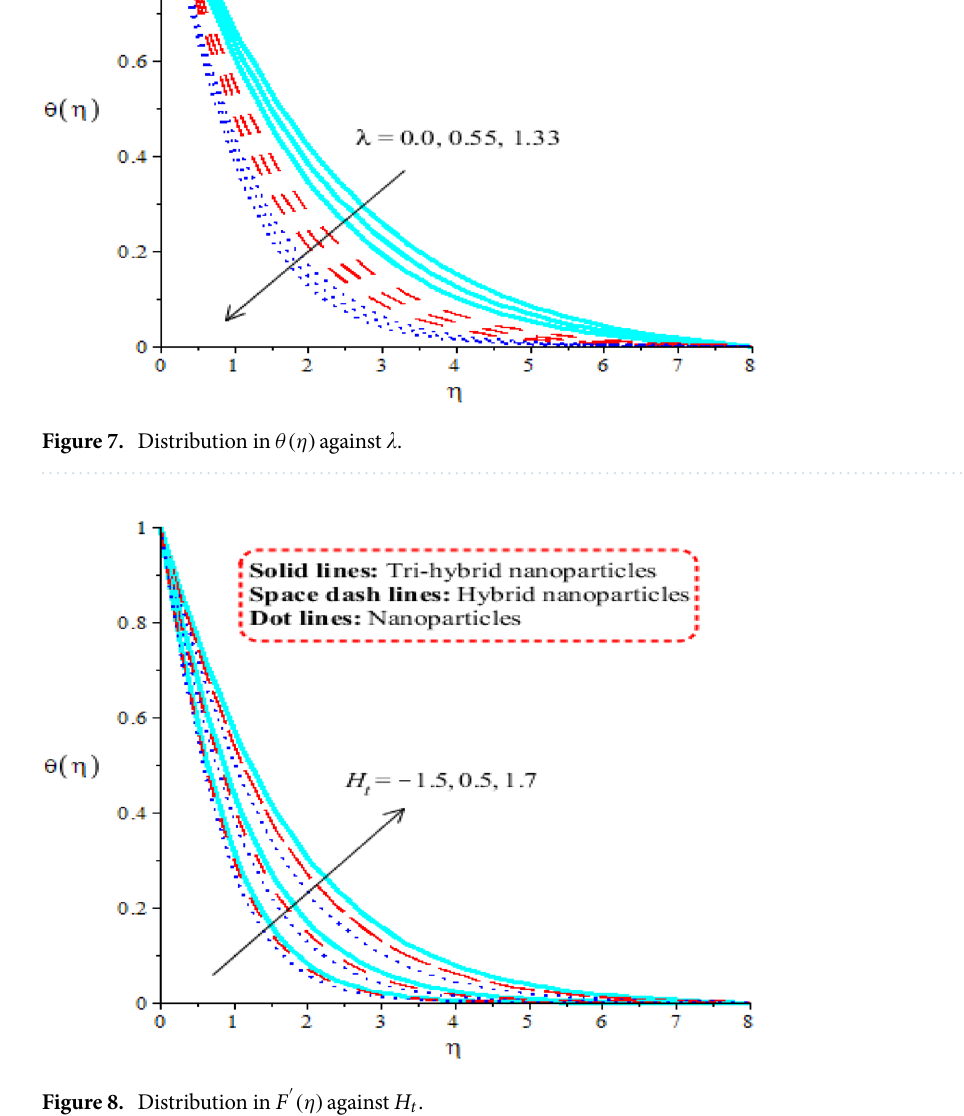
Figure 8. Distribution in F ′ (η) against H t